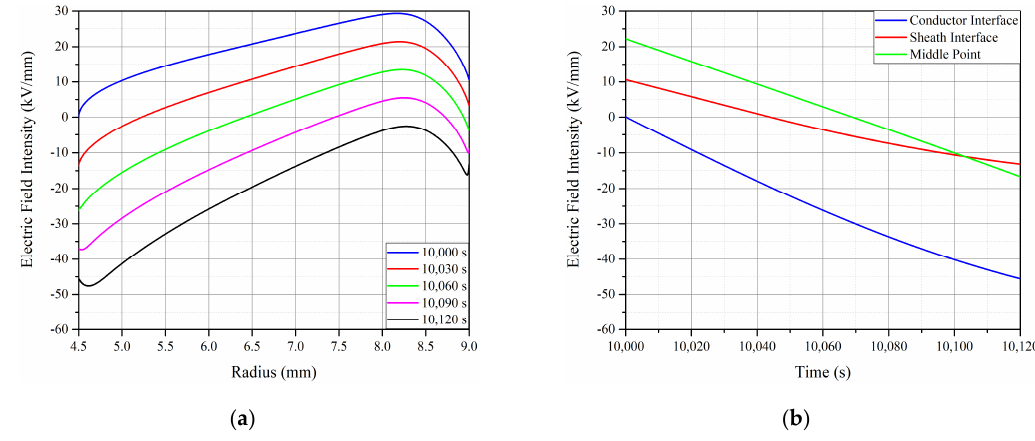
Figure 11. Time-varying electric field distribution at 350 A: ( a ) Within LDPE; ( b ) at each point.